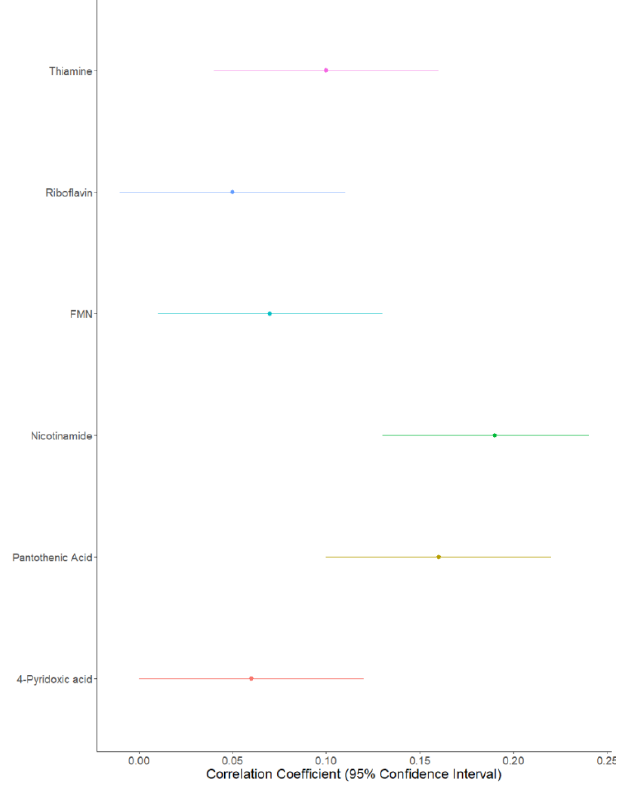
Figure 2. Forest plot of B vitamer correlations between parent–child pairs.